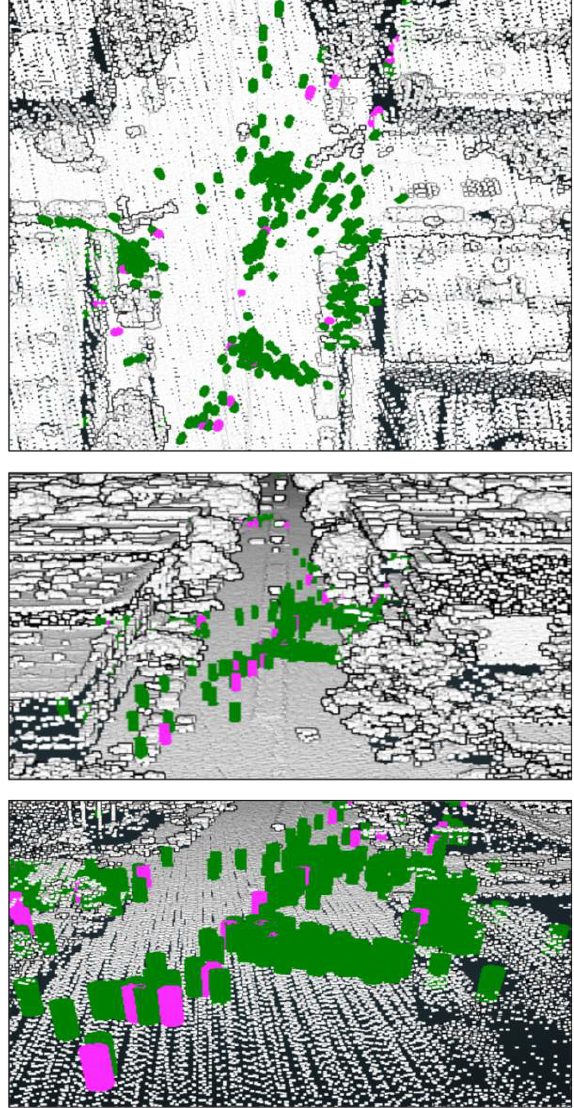
Figure 6. A set of 3D view of individuals in 3D space for the NYU Langone Hospital, Brooklyn, USA. Females in red and males in blue (Displayed data for all 1,578 points) This research extended the prior work on 2D heatmap visualization proposed in Carey et al. (2021) through defining colors for every feature (e.g. time type, gender, medical Personnel, PPE usage) and specific color shading for attribute values within every feature. This was achieved using dynamic vertex color shading and through drop-down filters to select features of choice in the Potree dashboard. Color scale legend in the Potree dashboard updates automatically when a particular feature from the dropdown menu is selected.